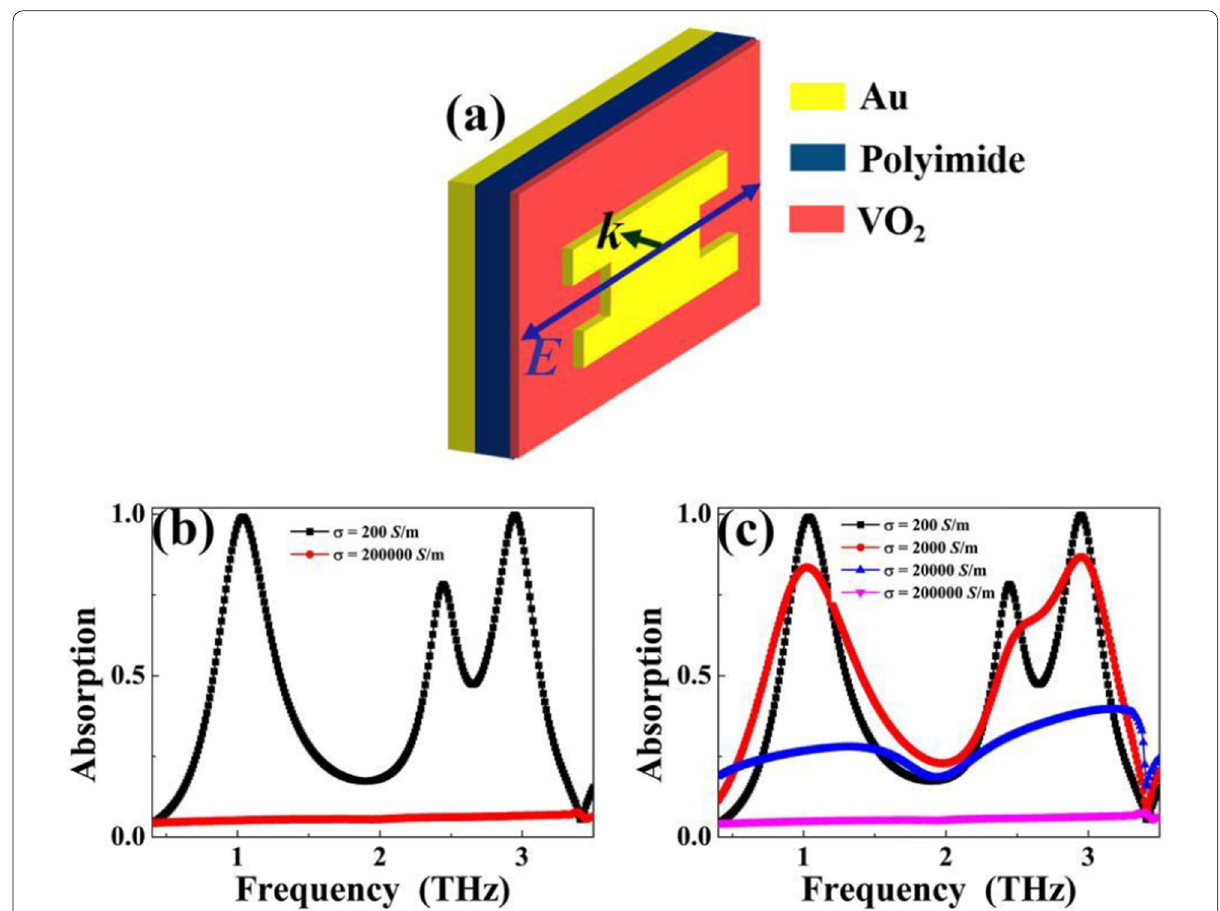
Fig. 7 a Three‑dimension structure sketch of tunable metamaterial absorber (case 2) by introducing VO 2 continuous layer with the thickness of 0.4 μm under the layer of analogy I‑typed resonator; b absorption curves of tunable terahertz metamaterial absorber (case 2) under conductivity values of σ 200 S/m and σ 200,000 S/m; c absorption curves of tunable metamaterial absorber (case 2) under conductivity = =